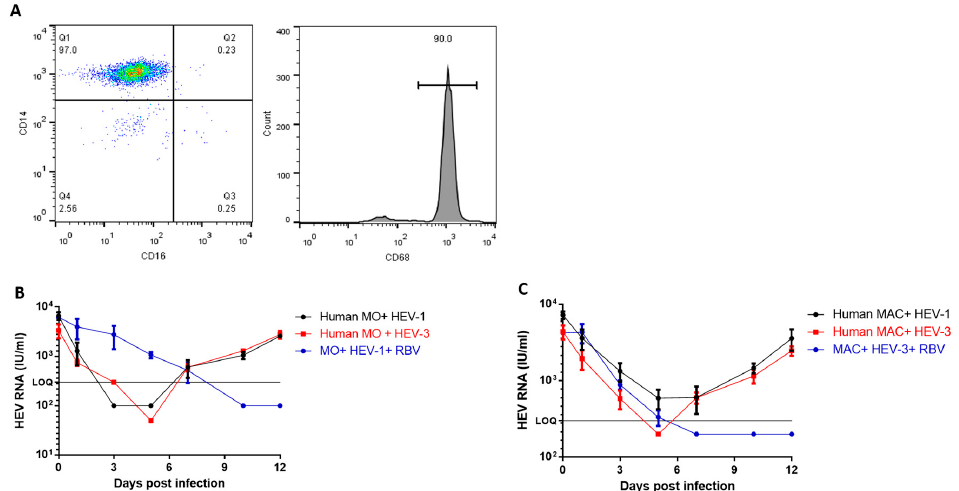
Figure 2. Characterization of human monocytes and macrophages and infection with HEV inoculums ( A ) The isolated human monocytes were analyzed by flow cytometry to check for purity, and isolated cells were stained with anti-CD14 and anti-CD16 (left). After di ff erentiation into macrophages, the cells expressed high levels of the intracellular marker CD68 (right). ( B ) Infection of human monocytes (HMOs) with HEV-1 (black) and HEV-3 (red) inoculums. HMOs challenged with HEV-1 were treated with ribavirin (RBV-50 um) (blue). Extracellular HEV RNA was quantified in the supernatants by qPCR. ( C ) Infection of human macrophages (HMACs) with HEV-1 (black) and HEV-3 (red) inoculums.